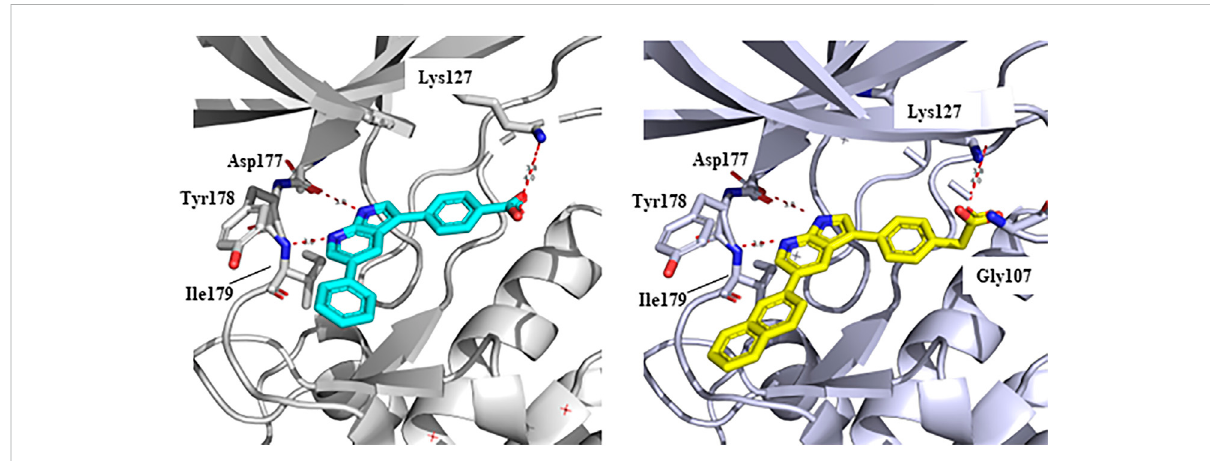
FIGURE 3 Co-crystal structures of SGK1 complexed with compound 1 ( 3 ) (left; PDB code: 3hdm) and 2 ( 4 ) (right; PDB code: 3hdn). Red dotted lines indicate hydrogen bonds between inhibitors and SGK1. SGK1, serum and glucocorticoid-regulated kinase